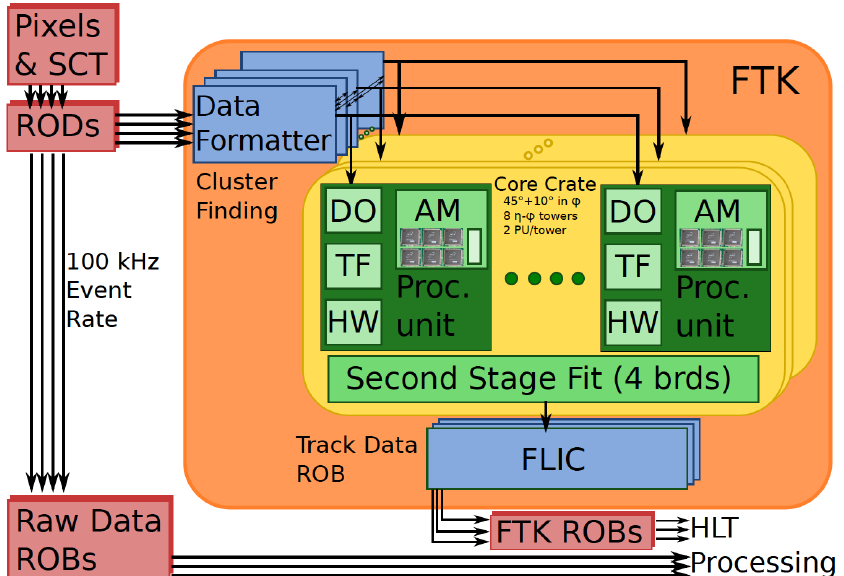
Figure 4. Functional sketch of FTK. AM is the Associative Memory, DO is the Data Organizer, FLIC is the FTK-to-Level-2 Interface Crate, HW is the Hit Warrior, ROB is the ATLAS Read Out input Buffer, ROD is a silicon detector Read Out Driver, and TF is the Track Fitter. Second Stage Fit is referred to as the Second Stage Board elsewhere in the